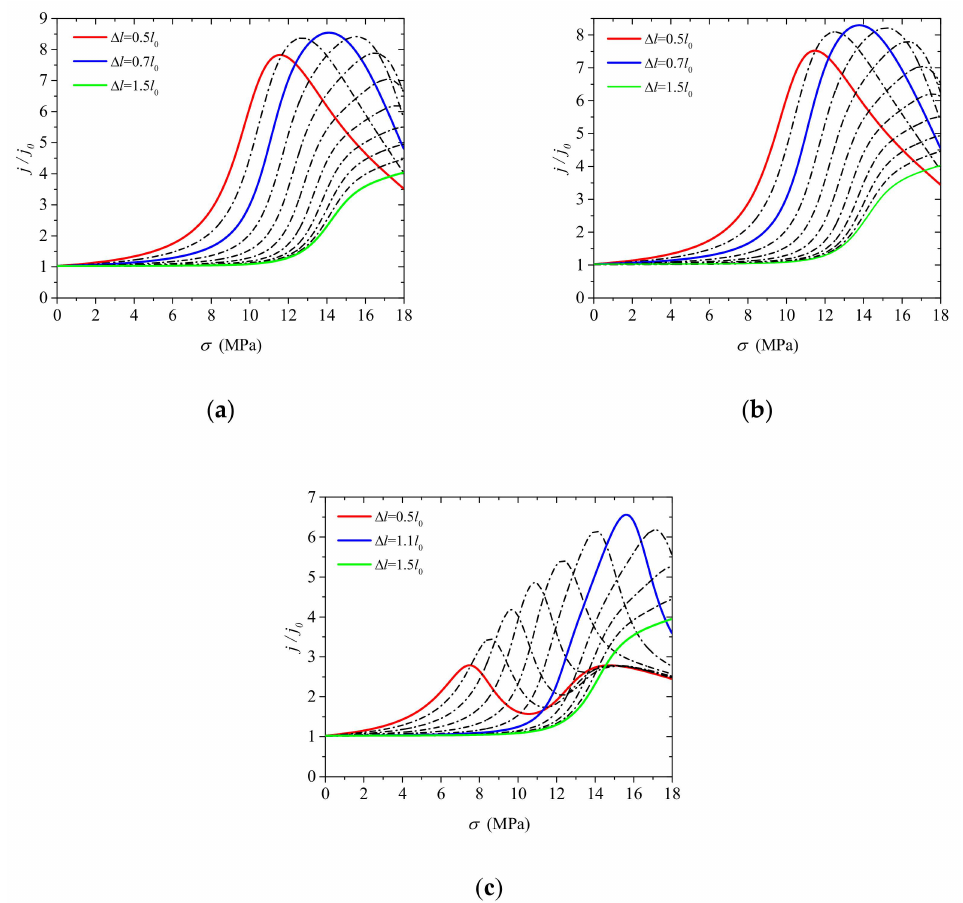
Figure 3. Variations in the output current density (at the PN junction) with stress under conditions of varying MIAPB positions. ( a ) L A / l 0 = 0, ( b ) L A / l 0 = 0.01, and ( c ) L A / l 0 = 0.1.